Question: Express in one sentence what the figure is showing.
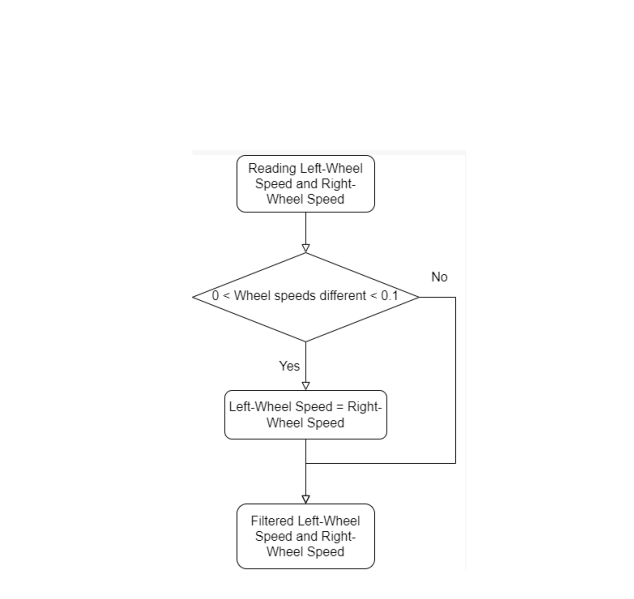
Answer: Filtering process for the left-wheel speed and right-wheel speed  reading.